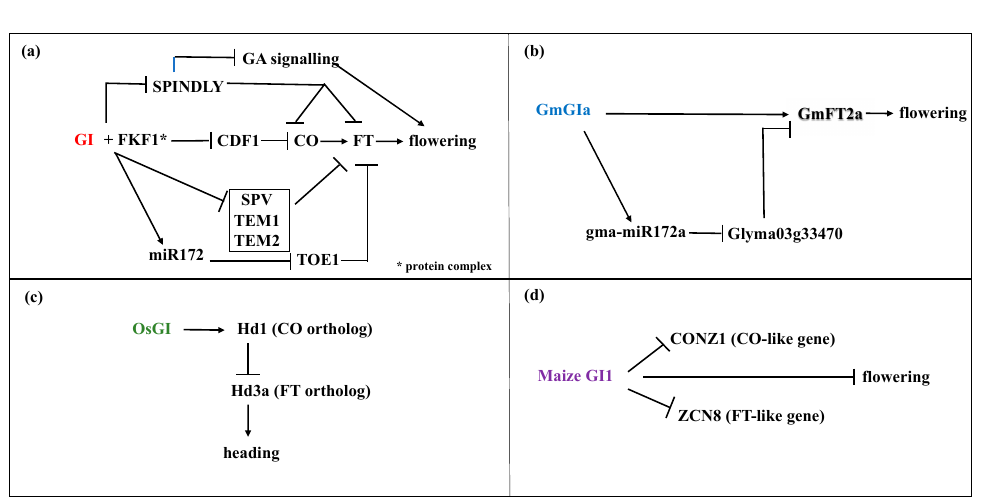
Figure 2. Models of GIGANTEA dependent flowering time regulation in ( a ) Arabidopsis, ( b ) soybean, ( c ) rice ( d ) and maize under long day condition. Regulation of flowering through GI differs between LD and SD plants. In contrast to LD plant Arabidopsis, OsGI inhibits flowering in rice, an SD plant, because the FT ortholog Hd3a is repressed by Hd1 , the CO ortholog.